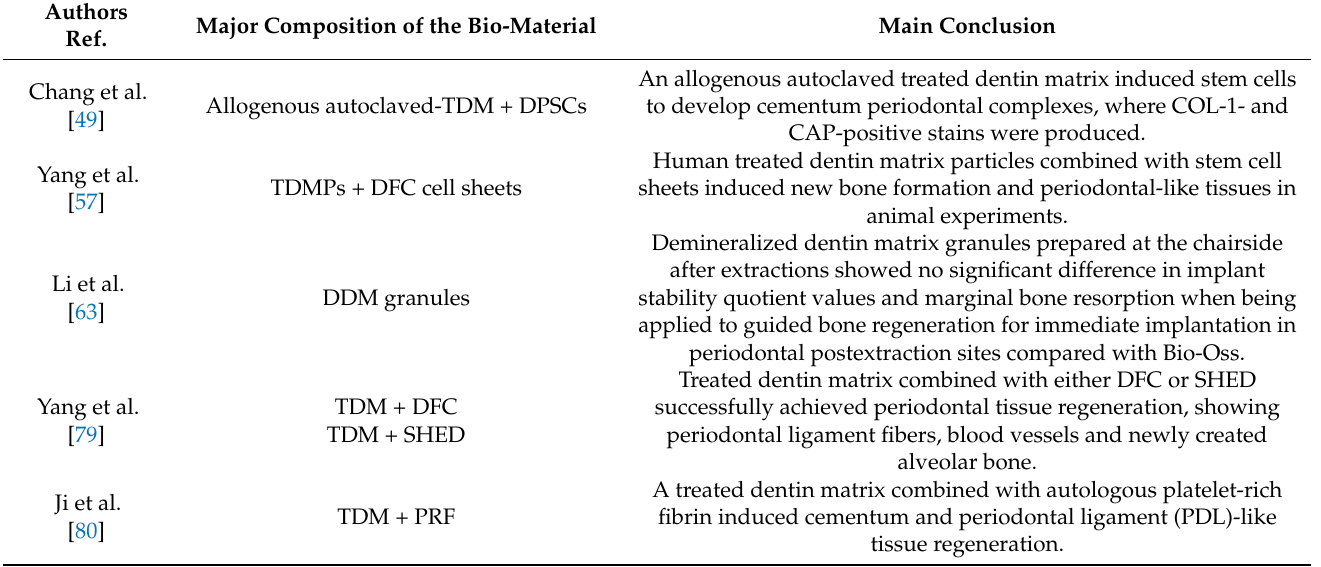
Table 5. Treated dentin matrix and its derivatives for periodontal tissue